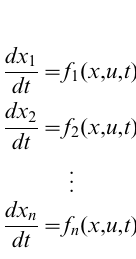
Figure 7. Entraining stimulus and corresponding limit cycle of the Jewett-Forger-Kronauer model. The top plot shows the entraining stimulus (LD-cycle) and the leftmost plot, the entrained limit cycle corresponding to this stimulus. Here pink corresponds to day and black to night. The middle plot shows the oscillations in the first coordinate of the entrained limit cycle. The last plot shows the phase of periodic stimulus or, equivalently, of the entrained oscillator. All significant features are labeled with the appropriate notation (See Methods, or Notation in supplemental text S1).